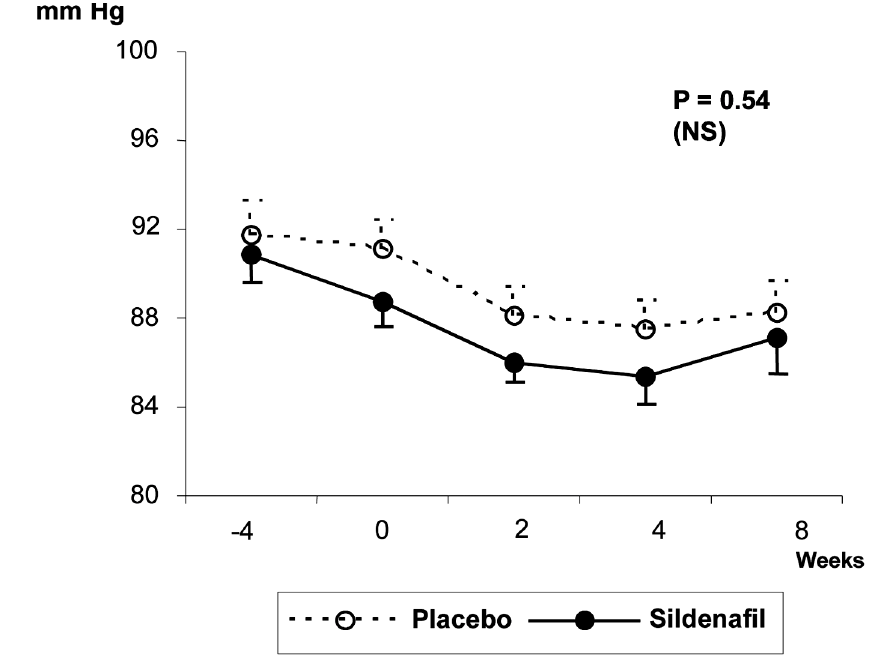
Figure 6 – Blood pressure (BP) behavior during the study. Diastolic BP in sitting position. P values refer to the comparisons be- tween sildenafil and placebo. NS = not